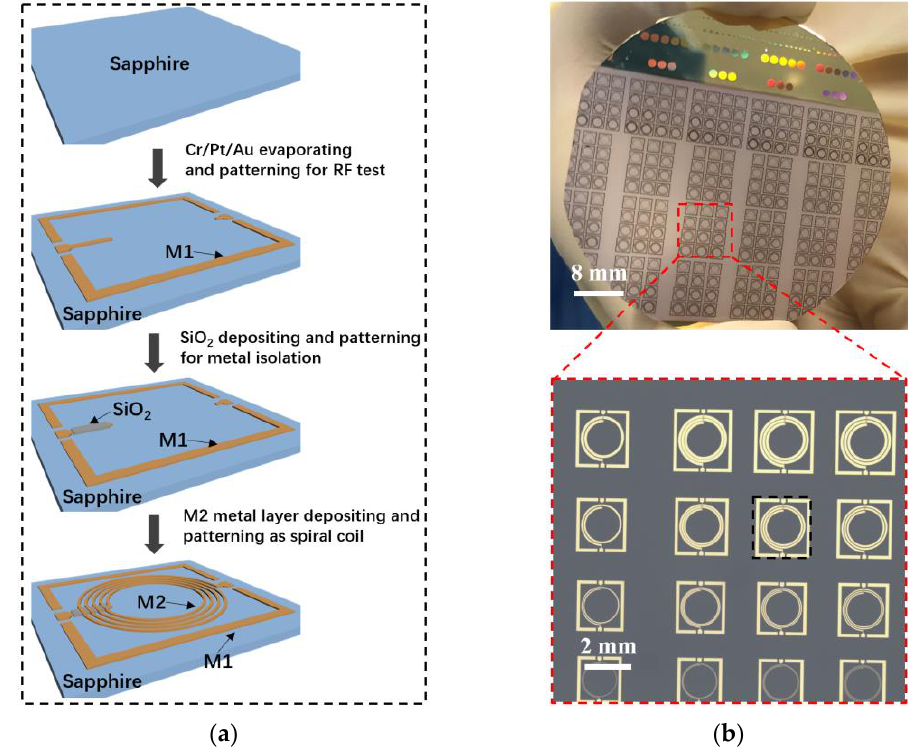
Figure 1. ( a ) Schematic diagram depicting fabrication process for a 4.5-turn inductor; ( b ) Optical and segmental microscope images of multiple spiral inductors on a 2-inch sapphire. (M1: Cr/Pt/Au, M2: Cu or Al-based metal multilayers, RF: radio-frequency)